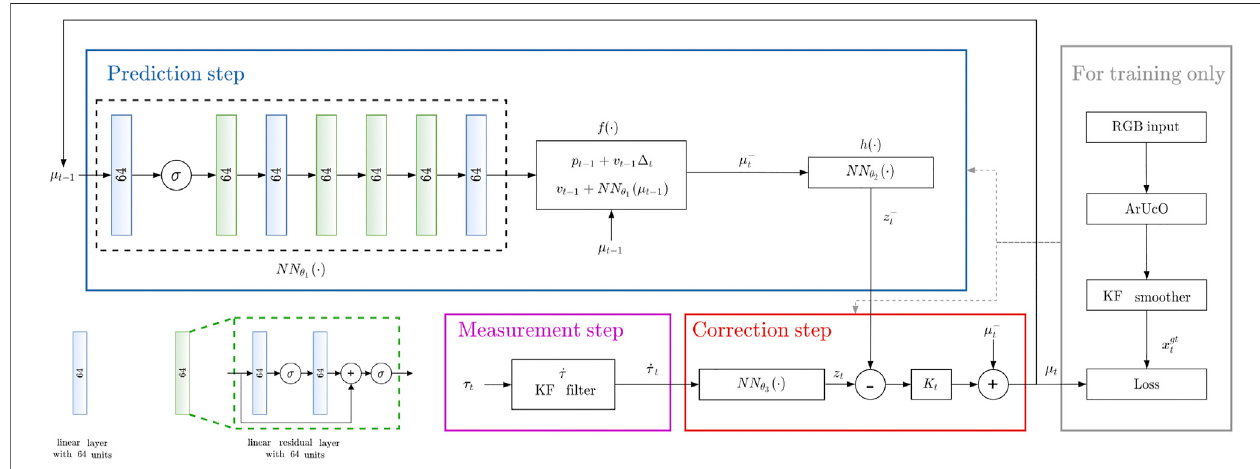
FIGURE 2 | Overview of the proposed differentiable fi ltering architecture for object sliding tracking. σ indicates the ReLU activation function.